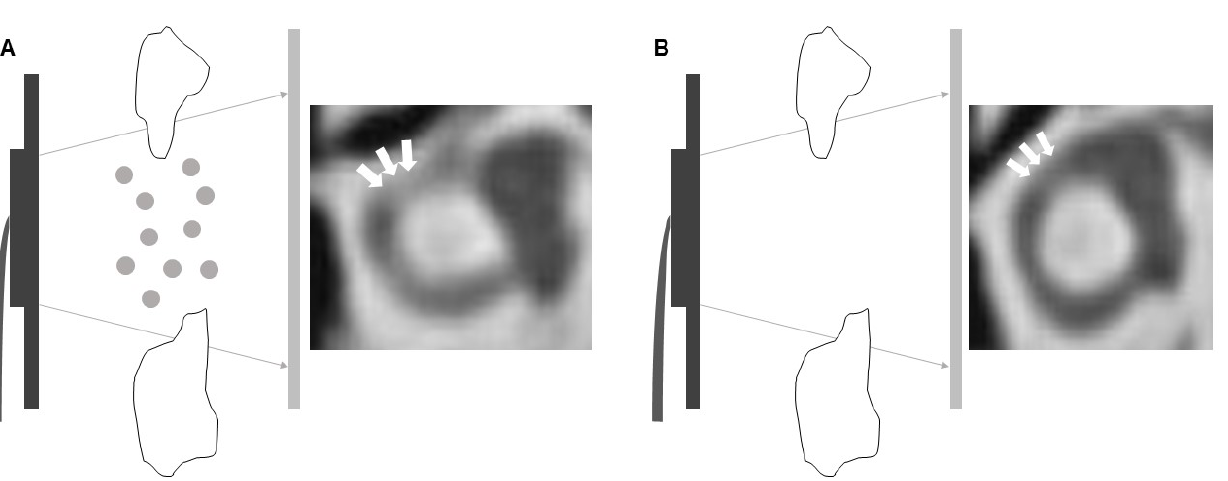
Figure 2. ( A ) The pathway of the X-ray beam was scattered by the suspend small particles (i.e., otolith here, size of 10 μ m) so that there was scattering effect found in the final HRCT image (i.e., snowy dot) (white arrow); ( B ) The pathway of the X-ray beam smoothly go through the target organ without any scattering. Therefore, the final HRCT image showed clean and clear (i.e., black) without any snowy dot detected (white arrow).